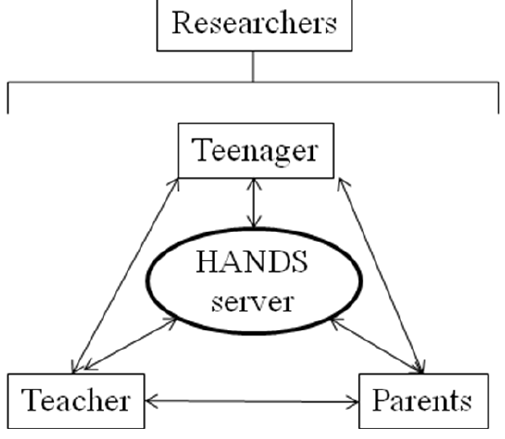
Figure 2. The general system architecture as seen from the user’s